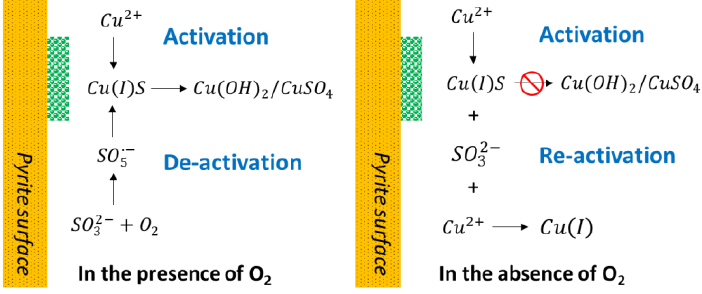
Figure 37. Schematic representation of the effect of MBS on the activation of copper on pyrite in the presence and absence of oxygen (adapted from Mu et al. [74]).